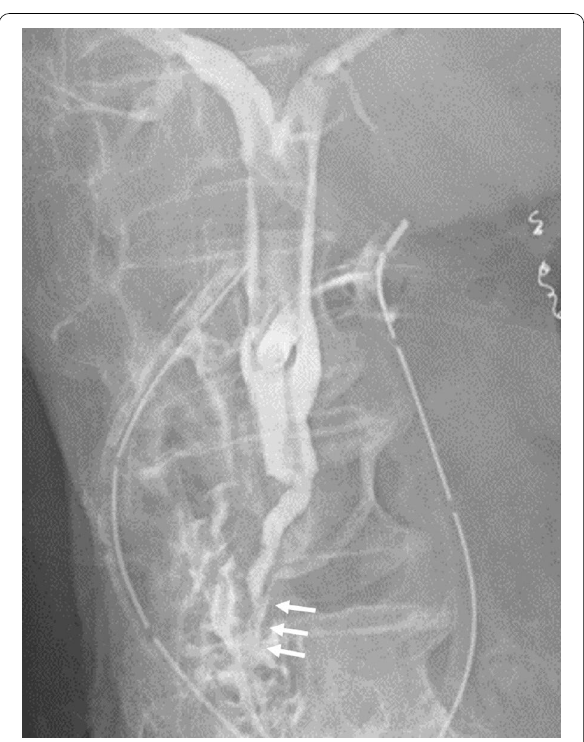
Fig.5 Postoperative T-tube cholangiogram. T-tube cholangiography on the 55th postoperative day confirmed that an impacted common bile duct stone had been removed naturally and that the long common channel of the pancreaticobiliary duct (arrow) clarified the diagnosis of pancreaticobiliary